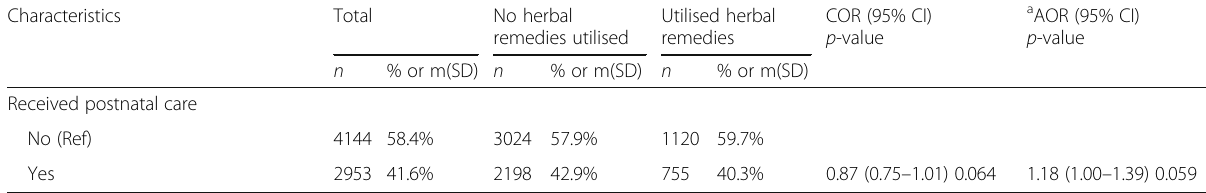
Table 1 Characteristics of participants and factors associated with utilisation of Mwanamphepo during pregnancy (Mixed-effects model, adjusted for clustering) (Continued)